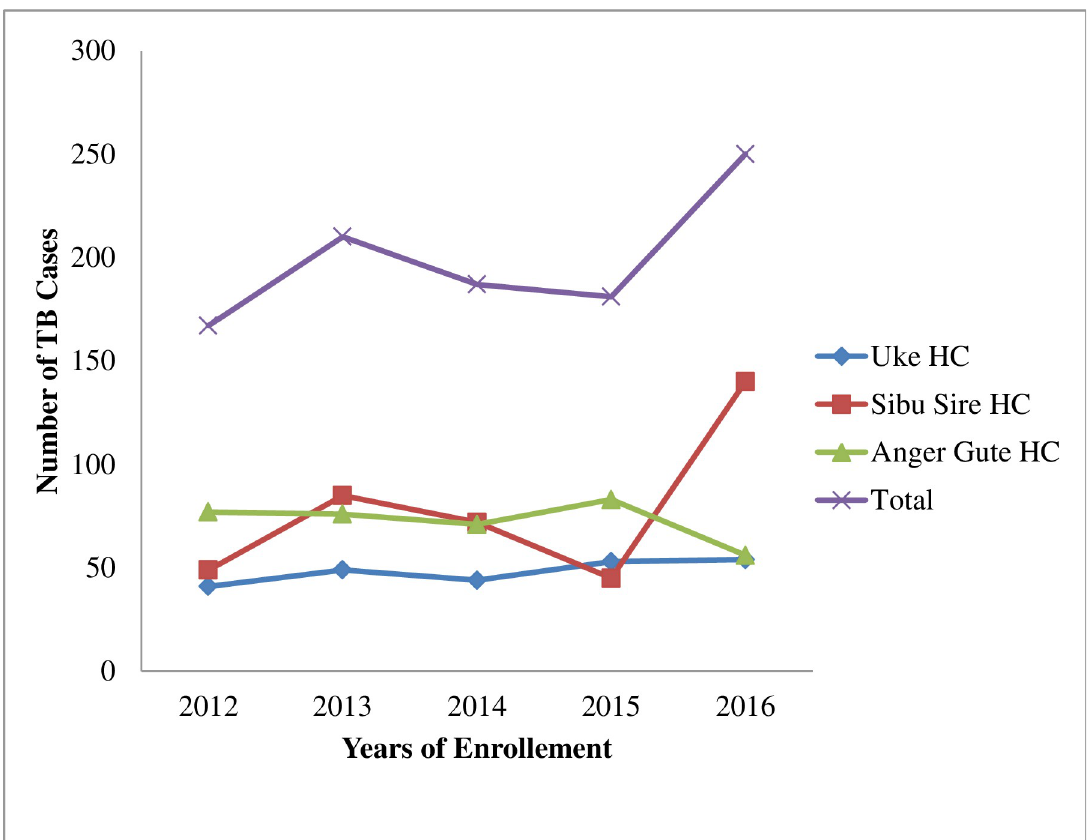
Fig 1. The case incidence of TB patients in three health centers in East Wollega from 2012 to 2016.HC,health center.